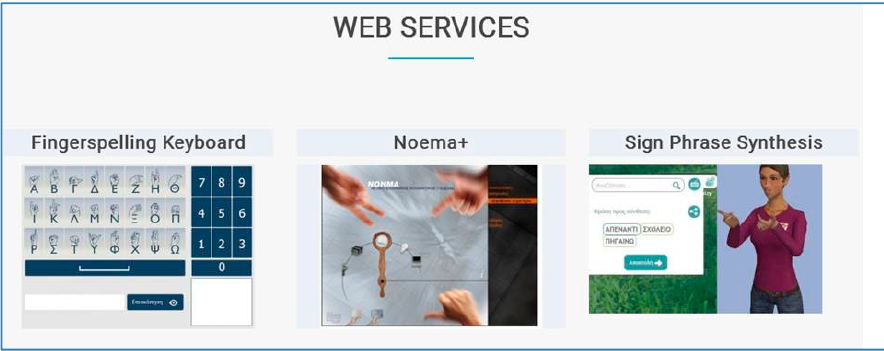
Figure 4. SL web services provided at: slt.ilsp.gr.